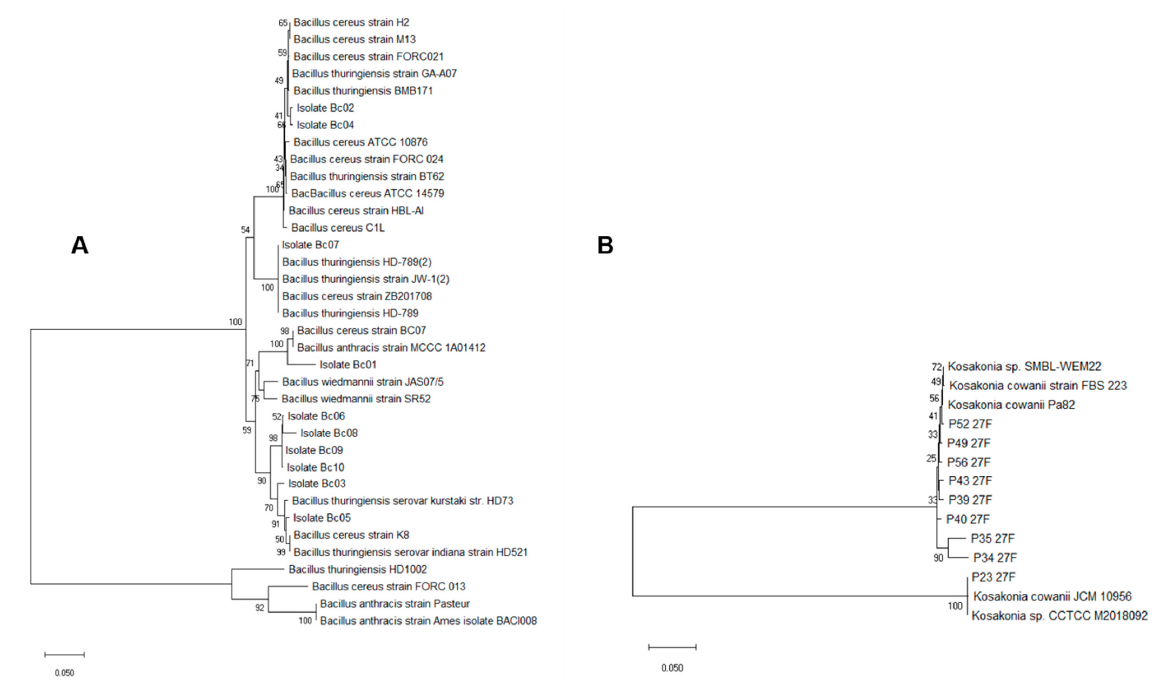
Figure 2. Phylogenetic analysis for B. cereus s.l . ( A ) and K. cowanii ( B ) isolates. Analyses were obtained in MEGA X, using the neighbor-joining method and the evolutionary distances were computed using the Jukes–Cantor method